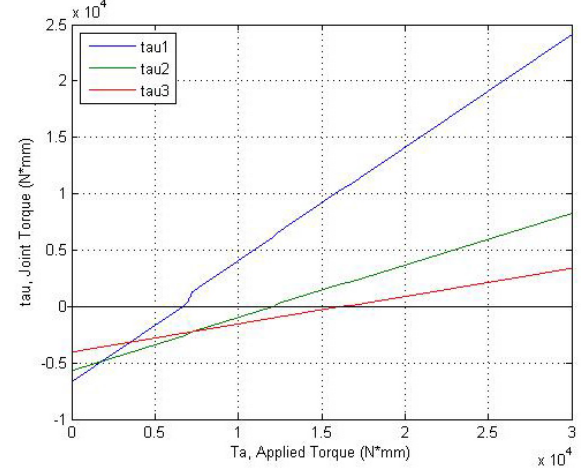
Figure 5. Closing sequence for the finger